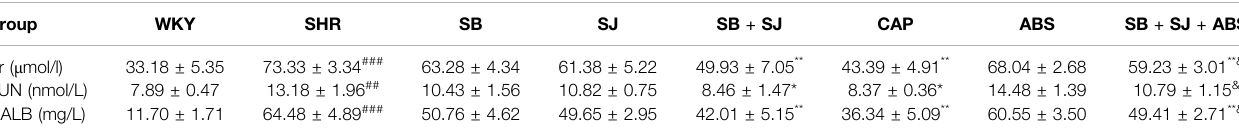
TABLE 3 | Effects of thecombination of SB and SJ on kidney injury based on renal function biomarkers. Group WKY SHR